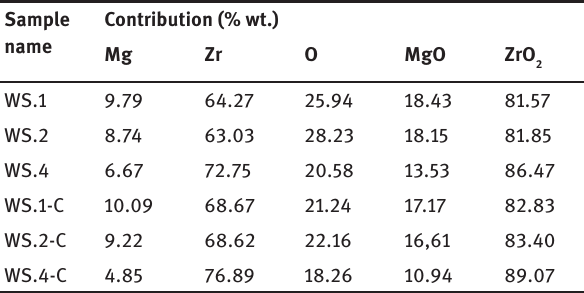
Table 3: Analysis of the surface composition of MgO-ZrO